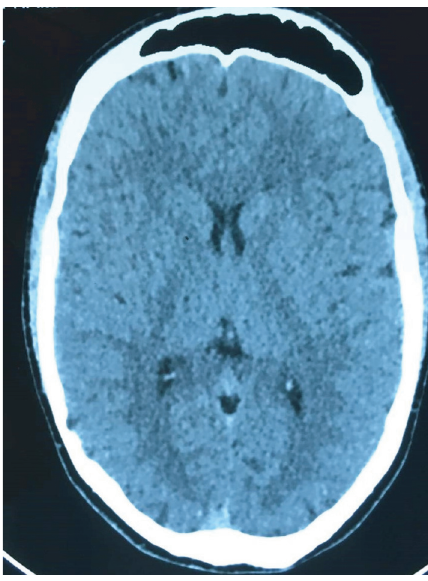
Figure 1: Normal cerebral CT scan.